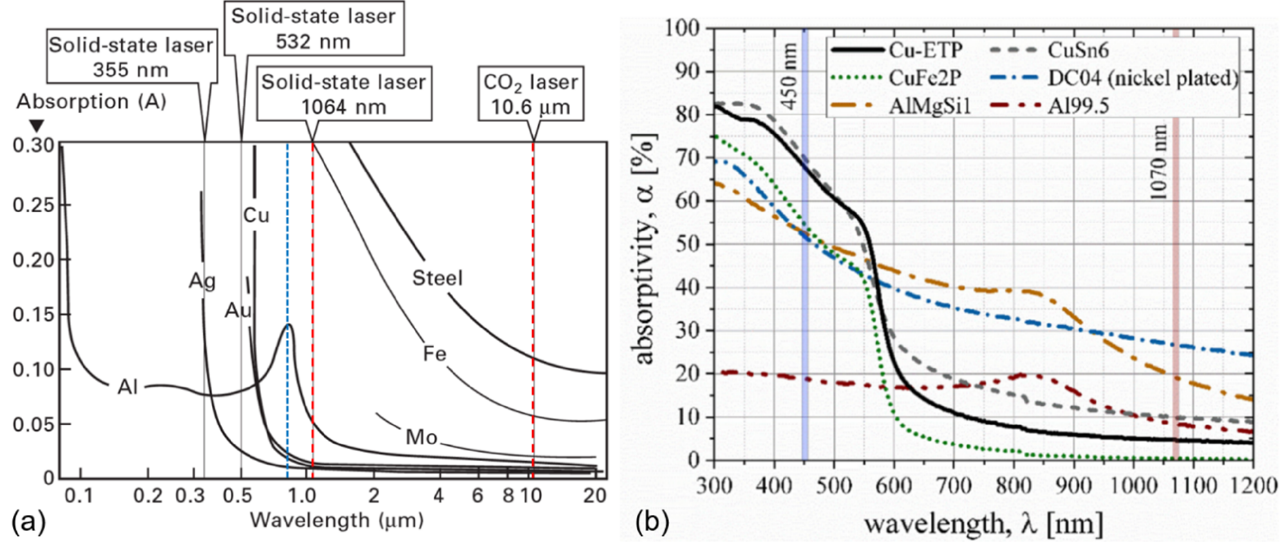
Figure 3. Absorption coefficient of different metallic materials depending on laser wavelength: ( a ) wide spectrum, based on [30]; ( b ) short-wavelength lasers, based on [23].